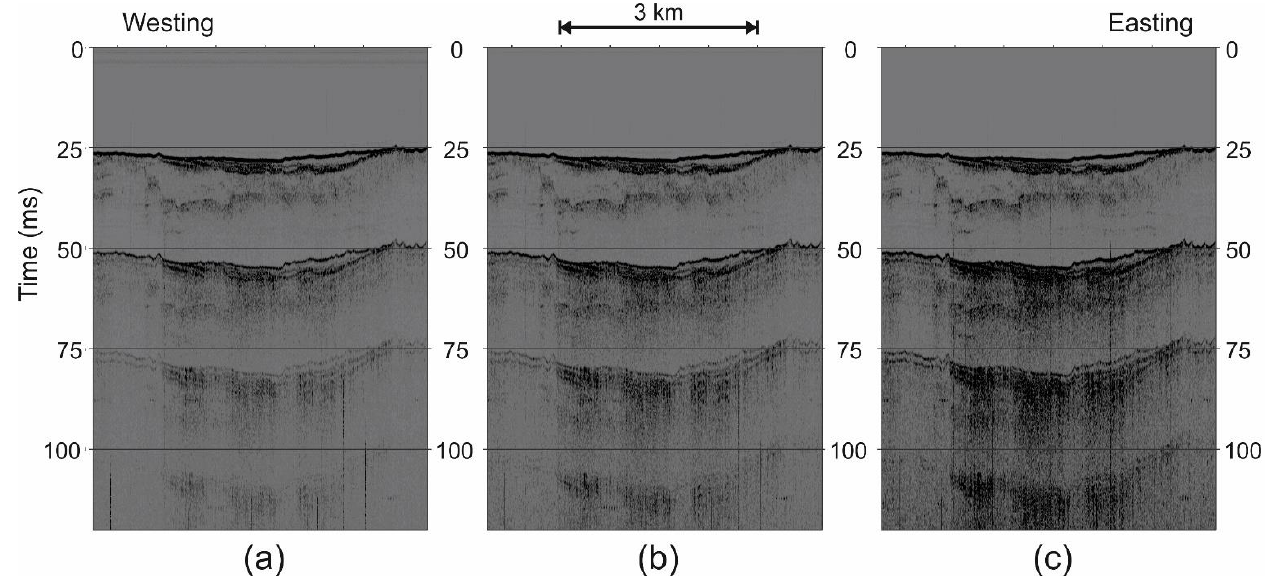
Figure 4. The same data as in Figure 3 using three different a exponent values for the gain curve t α : α = 1 ( a ), α = 2 + β = 2 − 0.527 = 1.473 ( b ), and α = 2 ( c ).